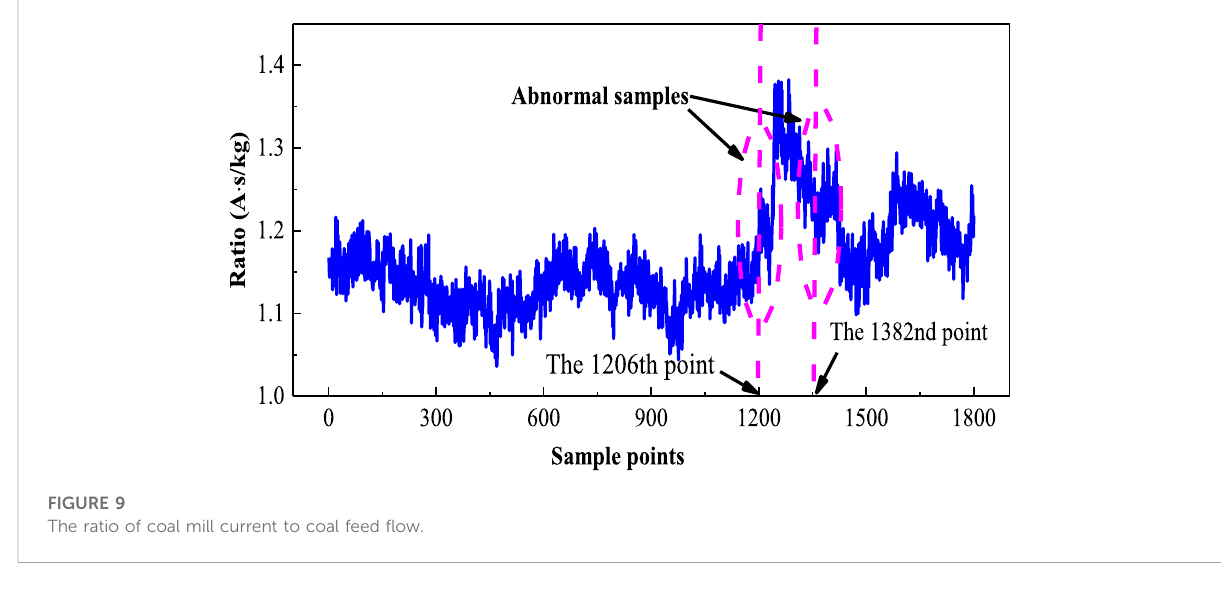
FIGURE 9 The ratio of coal mill current to coal feed fl ow.